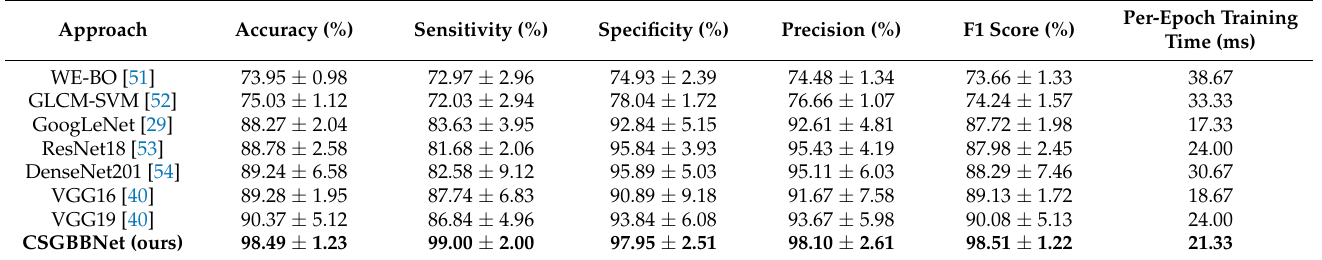
Table 8. Comparison with state-of-the-art approaches on the test set.